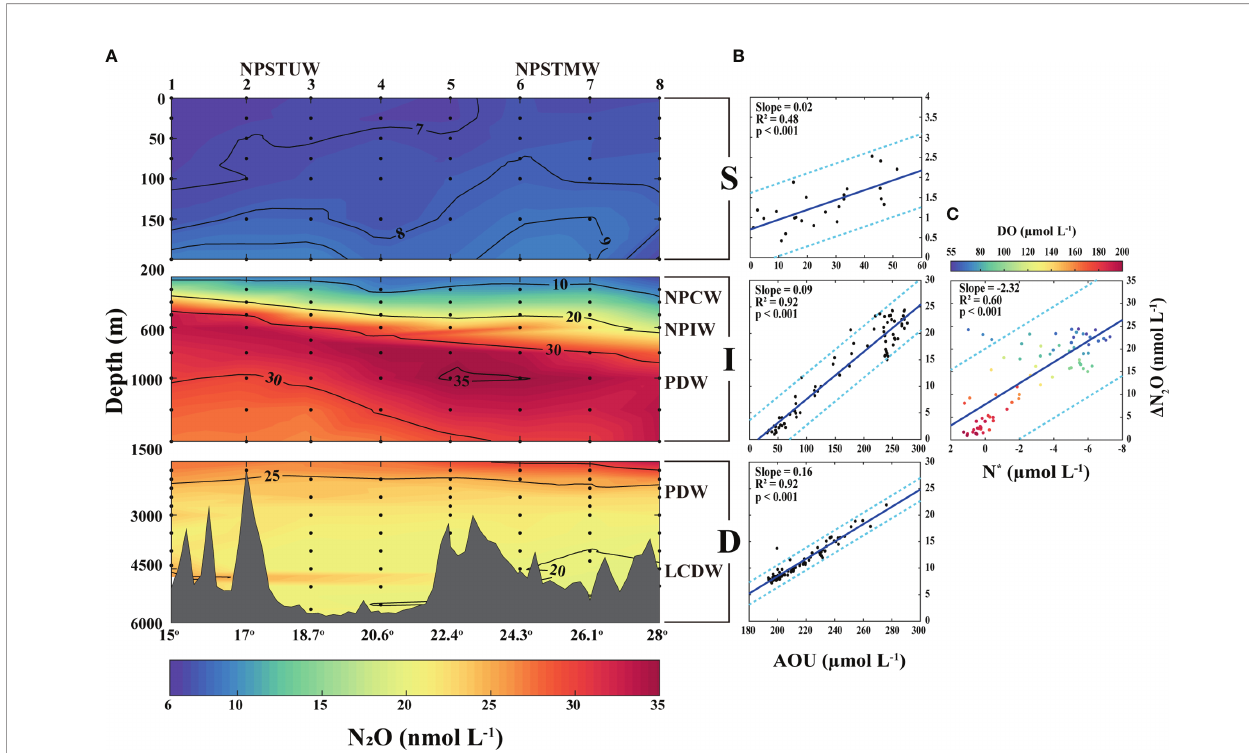
FIGURE 3 | (A) Vertical pro fi ling of N 2 O concentrations at the surface (0 – 200 m), intermediate (200 – 1500 m), and deep (1500 – 5774 m) layers of the STWNPO during this investigation. The black solid lines represent the contour lines and the abbreviations of water masses indicate the distribution of water masses. The top and bottom of the x -axis represent the station numbers and latitudes, respectively. (B) Correlations of D N 2 O with AOU and (C) N* at each layer. The blue lines and cyan dotted lines represent the model I linear regression and 95% prediction interval, respectively. The correlations of D N 2 O with N* at the intermediate layer are labeled with DO. This fi gure is also available with a gray color version in Supplementary Materials